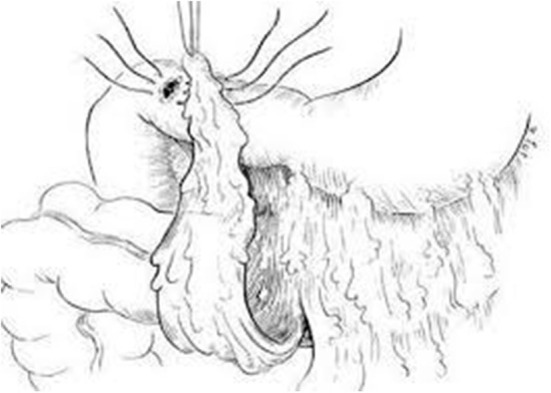
Schematic diagram of pedicled omental flap repair of perforated duodenal ulcer.